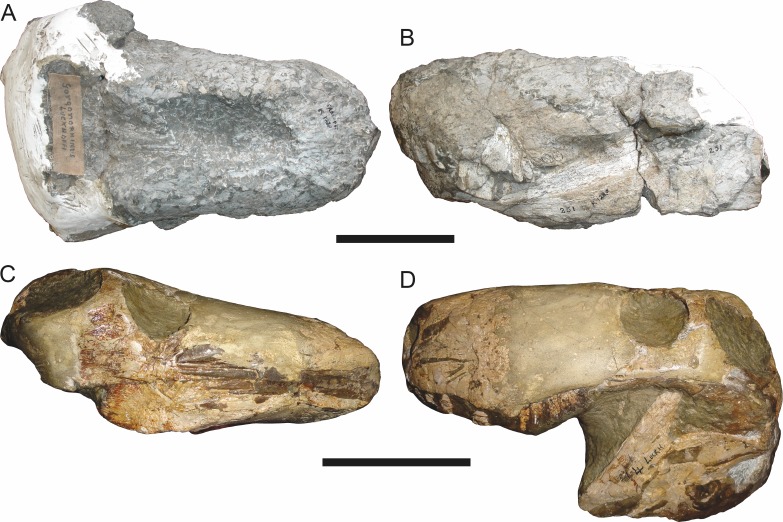
Referred specimens of Aelurognathus tigriceps (Broom & Haughton, 1913).SAM-PK-K1280 (holotype of Gorgonorhinus luckhoffi
Broom, 1937) in (A) dorsal and (B) left lateral view; RC 110 (holotype of Gorgonorhinus minor
Broom, 1948) in (C) dorsal and (D) left lateral view. Scale bars equal 10 cm.